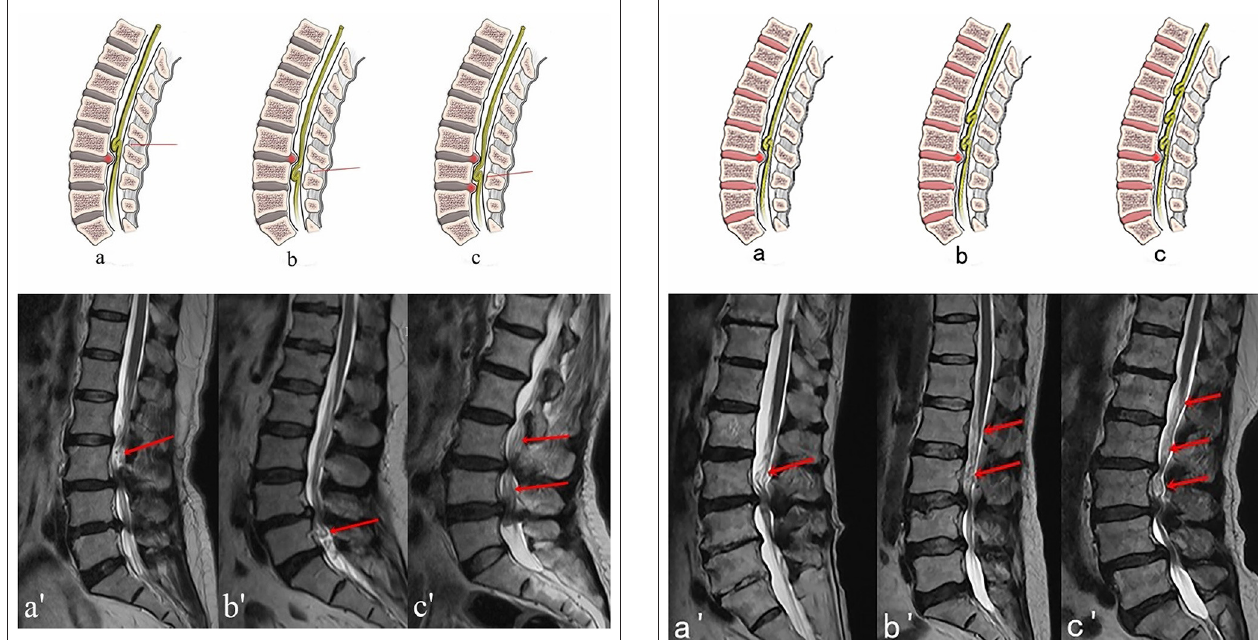
FIGURE 2 | Three possible subtypes of Upper RNRs (RNRs which are above the stenosis) with corresponding MRI images. (A,A ′ ) One segment of RNRs (red arrow) are above the stenosis. (B,B ′ ) Two segments of RNRs (red arrows) are above the stenosis. (C,C ′ ) Three segments of RNRs (red arrows) are above the